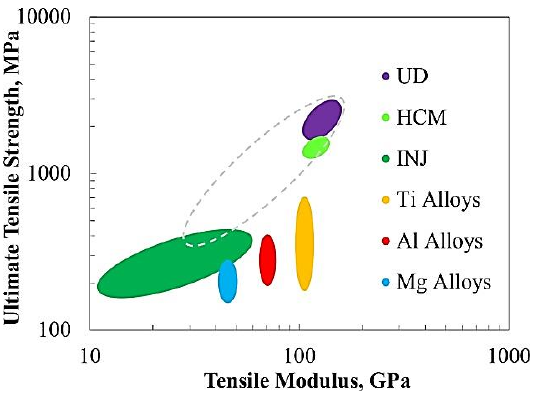
Figure 4. Typical tensile properties of common metallic alloys and CF-reinforced PAEK-based composites: UD, unidirectional fibers; HCM, hot compression molded fibers; INJ, injection molded fibers. Figure is reproduced with permission from reference [19].